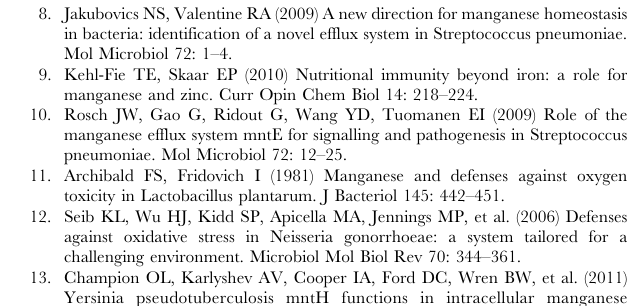
Figure S1 Disk assay of bacterial sensitivity to 1M MnCl 2 for X. campestris wild type and mutants lacking all combination of mntH , mntR or mntX . Figure S2 Phylogenetic patterns of MntX sequence conserva- tion. A) MntX family tree topology established by the Neighbor- Joining method using unequal rate of evolution across sites and tested with 3000 bootstrap resampling. Tree branch colors reflect the taxonomic distribution of the sequences sampled: proteobac- teria from a -, b -, c -, d - and e -divisions; Gram positive bacteria, including Firmicutes and Actinobacteria; Green Non Sulfur bacteria, Cyanobacteria, Fusobacteria Chlorobi/Flavobacter- iales/Bacteroidetes; Bacteria (Deferribacteres, Synergistetes, Lenti- sphaerae and Elusimicrobia) and Archaea (Euryarchaeota, Korarchaeota). The hierarchically ordered groups of sequences that were used for producing logos (shown in panel 2B): Pink (195 sequences: The MntH familly); blue (6 sequences: The outgroup); orange (32 sequences, including Neisseria meningitis and Xanthomonas campestris homologs indicated in green and purple, respectively). In addition each branch of the tree was colored in function of the phylogenic taxa. B) Sequence logos demonstrating preferential sequence conservation of MntX predicted TMS. MntX amino- and carboxy-internal repeats are shown superposed (top and bottom, respectively). MntX most conserved sites are boxed in red. Blue + indicate conserved positive charge clusters (predicted topogenic signals). In and Out symbols correspond to the positions of extra-membranous loops, respectively predicted to lie inside or outside the cell, and which are short and little conserved. Direct